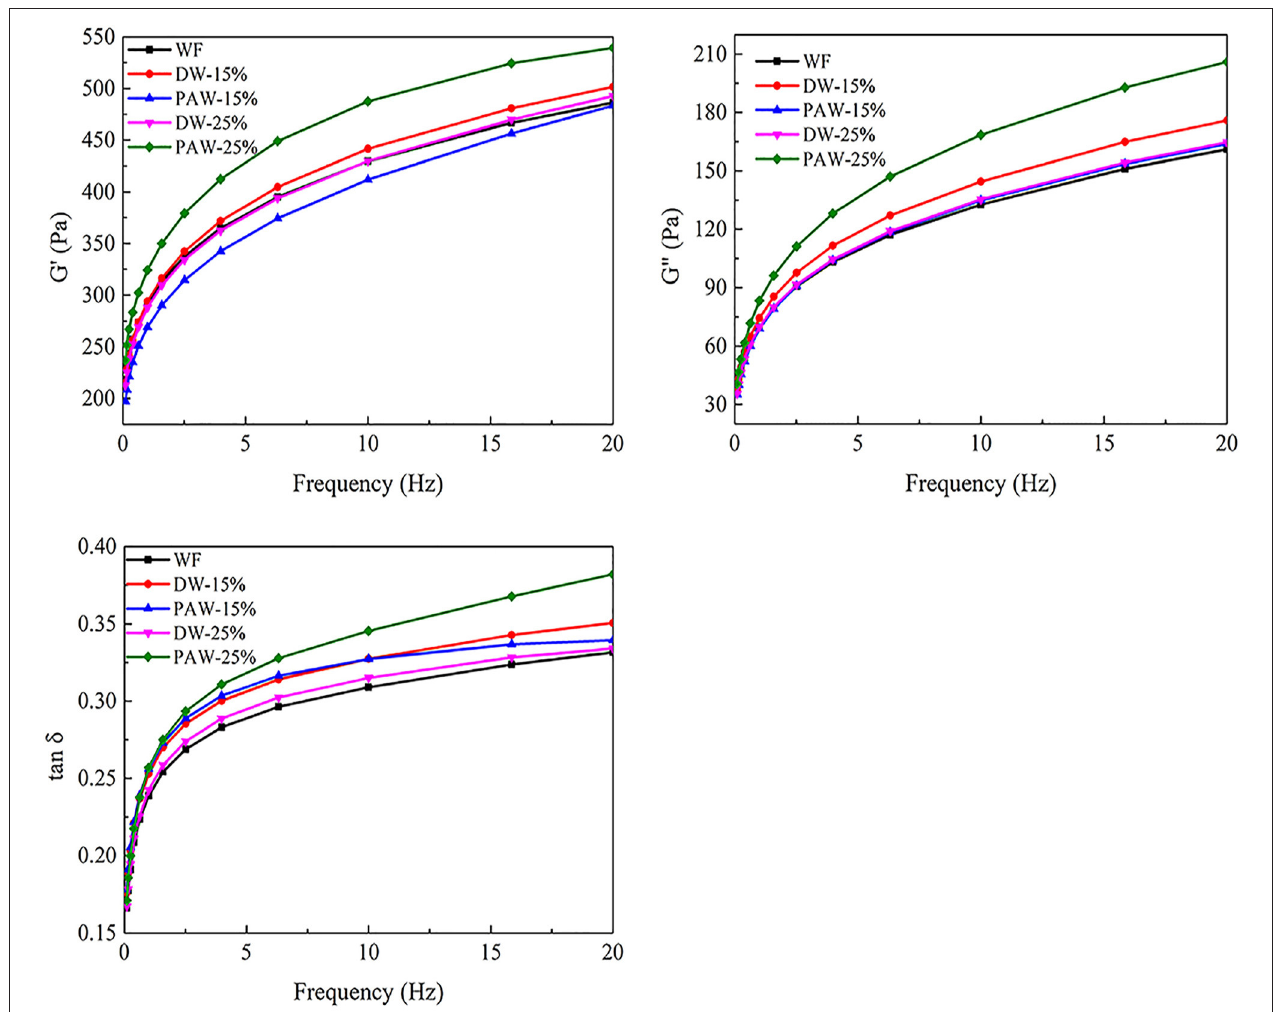
FIGURE 3 | Rheological properties of wheat flour. Storage modulus (G’), loss modulus (G”), dynamic loss tangent (tan δ